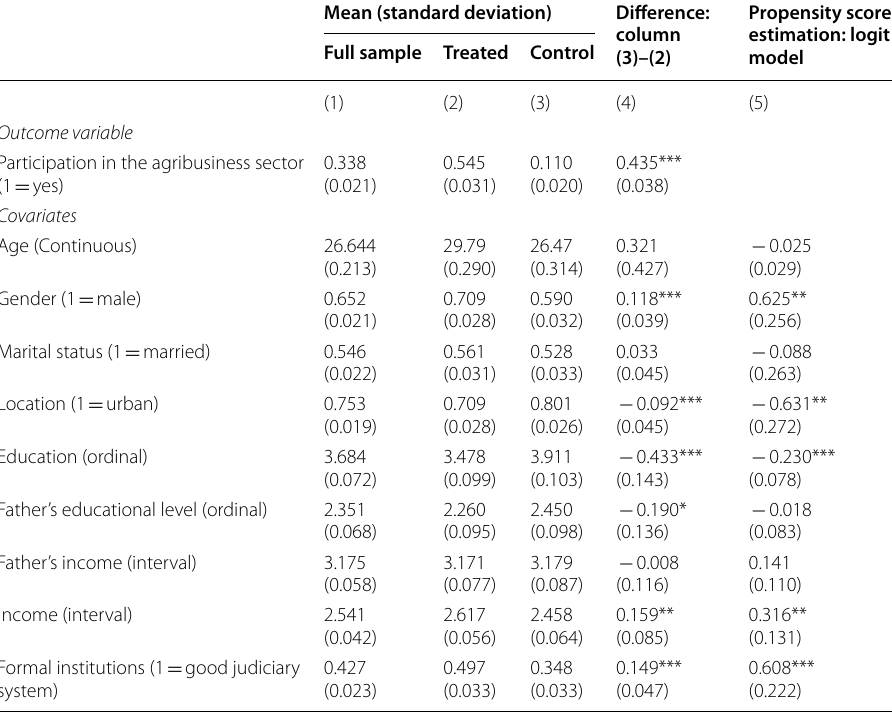
Table 2 Descriptive statistics of main variables and logit model. Source : Authors’ computations,